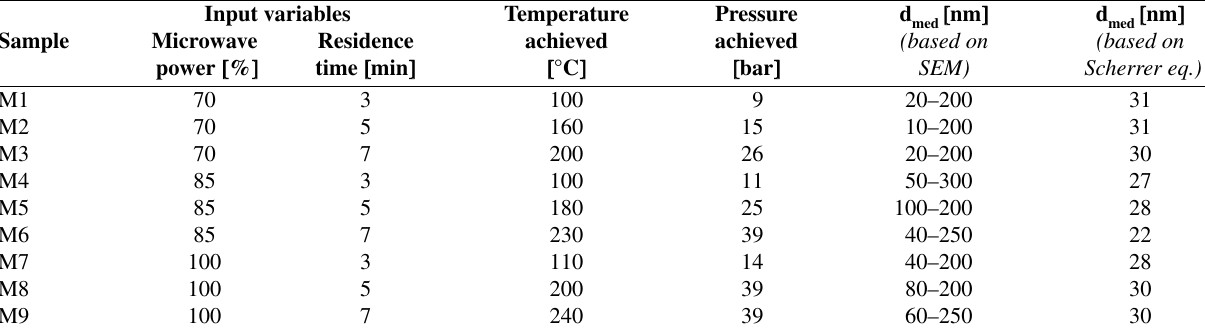
Table 2. Parameters of dehydration processes carried out in microwave reactor Input variables